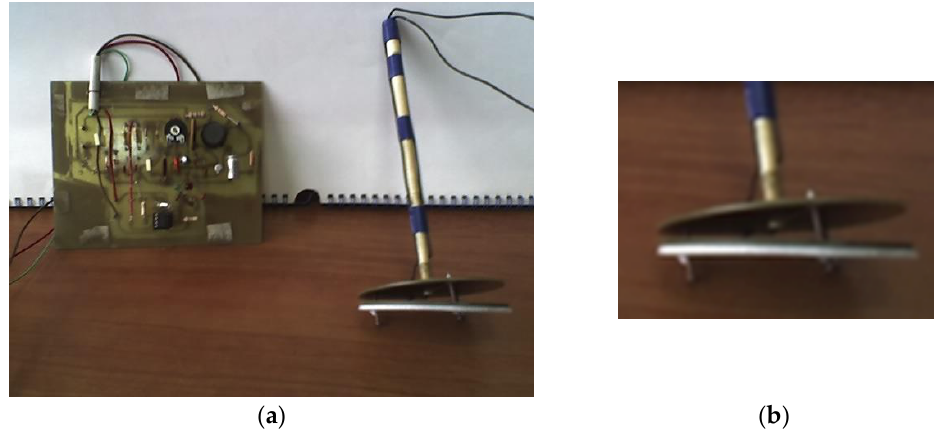
Figure 11. Liquid nitrogen-level sensor. ( a ) Experimental version; ( b ) zoom in on coplanar plates.